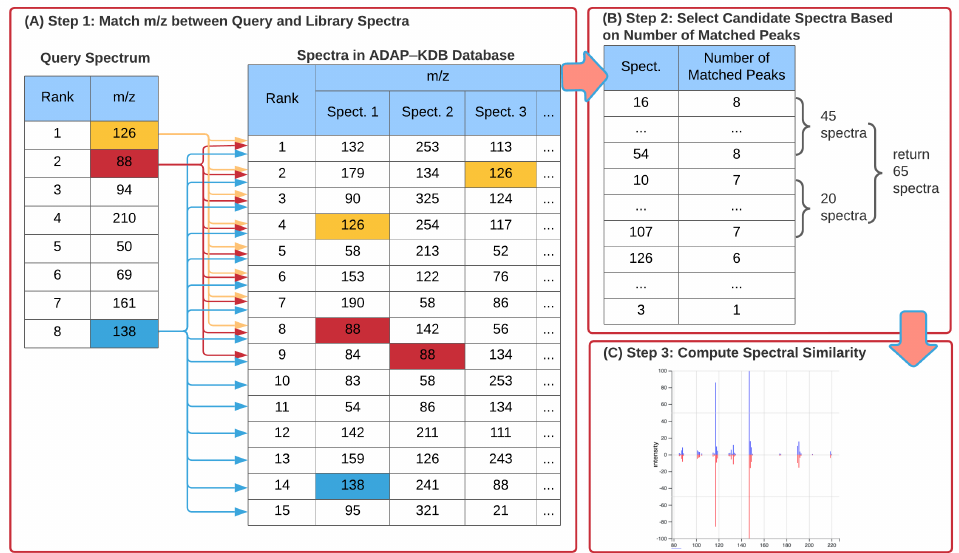
Figure 1. New ADAP-KDB spectral search algorithm with the prescreening search: ( A ) m / z values of 8 largest peaks in the query spectrum are matched to m / z values of 15 largest peaks in every library spectrum; ( B ) all library spectra are ranked based on the number of matched m / z values, and top 50+ candidate spectra are returned by the prescreening search; ( C ) the similarity score is calculated for each candidate